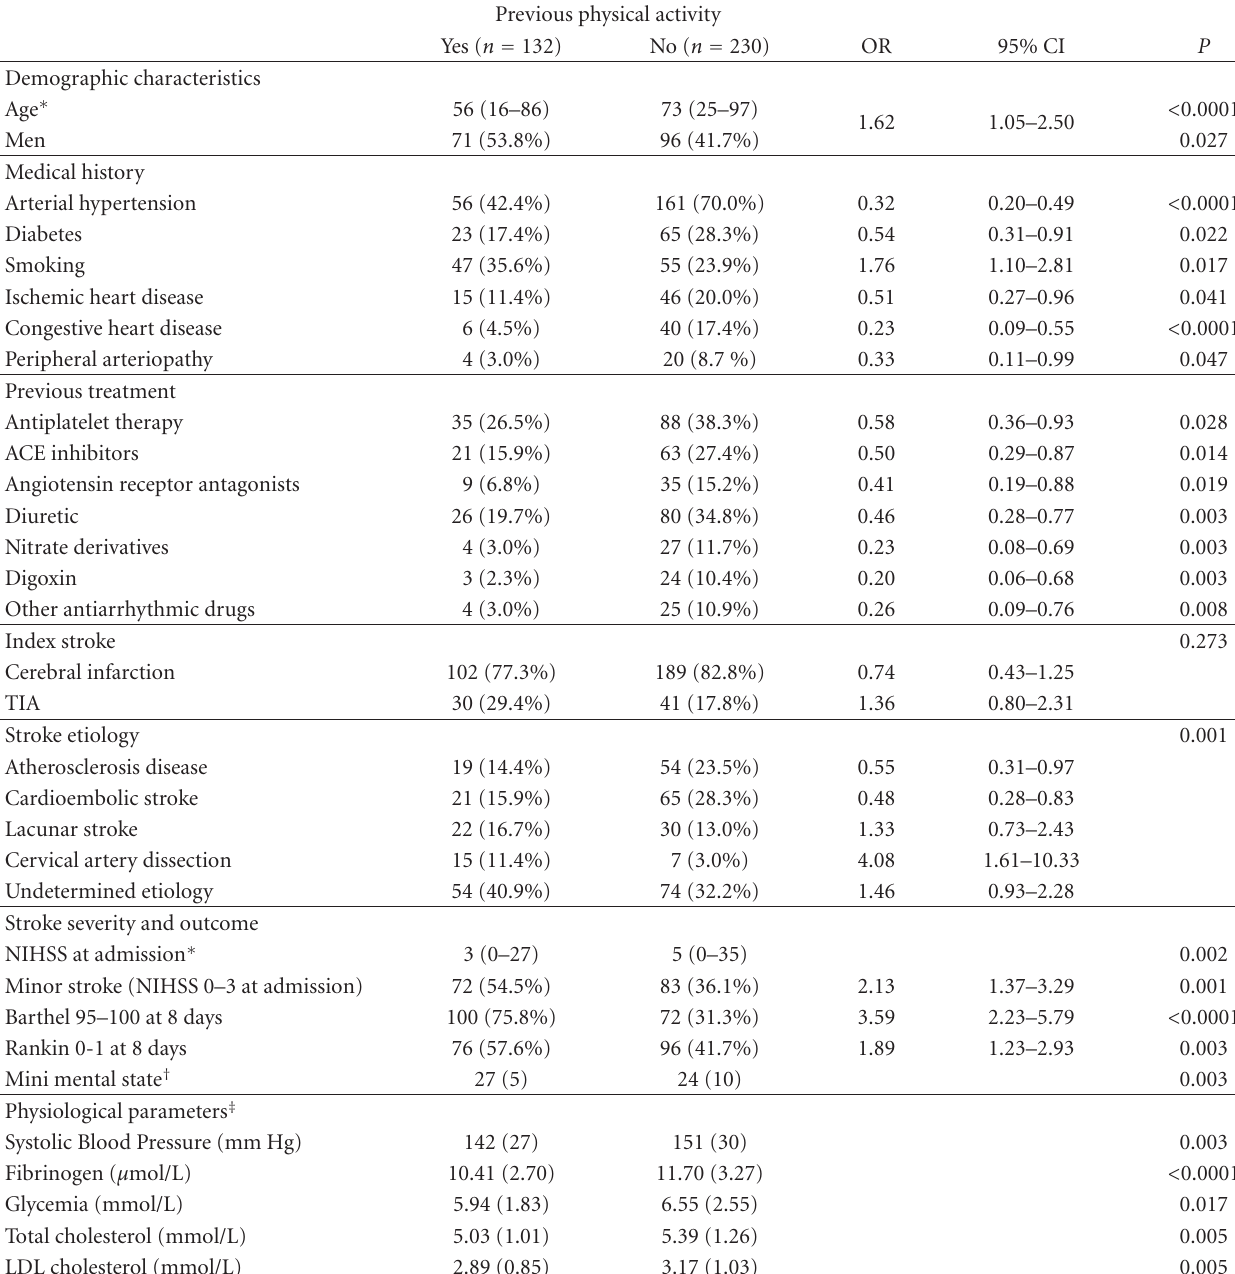
Table 1: Main characteristics according to physical activity status before